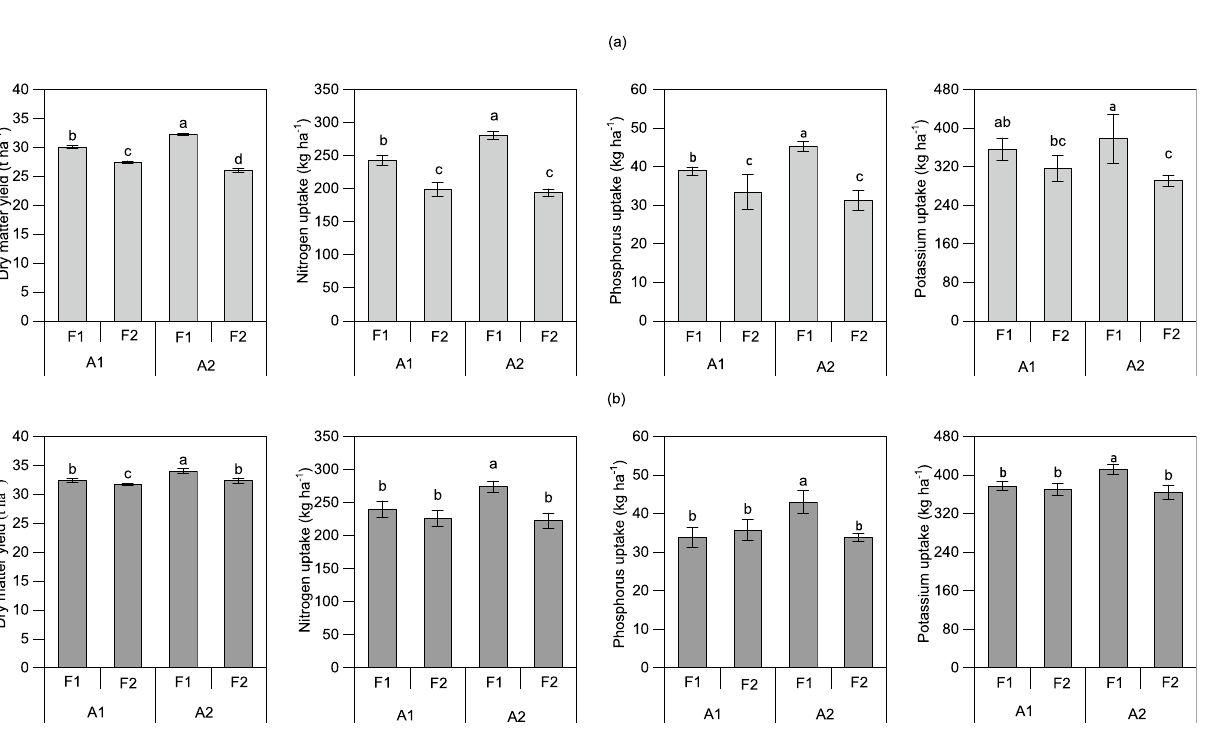
Figure 4. Effects of dripline spacing and fertilization rate on dry matter yield and nutrient uptake of summer maize in 2017 ( a ) and 2018 ( b ). Values within a column followed by different letters are significantly different at the 0.05 probability level. Error bars show ± standard deviation. A1, A2, and F1, F2 represent dripline spacing and fertilization rate, respectively, as shown in Fig. 2 and Table 2. Graphs were created using Origin